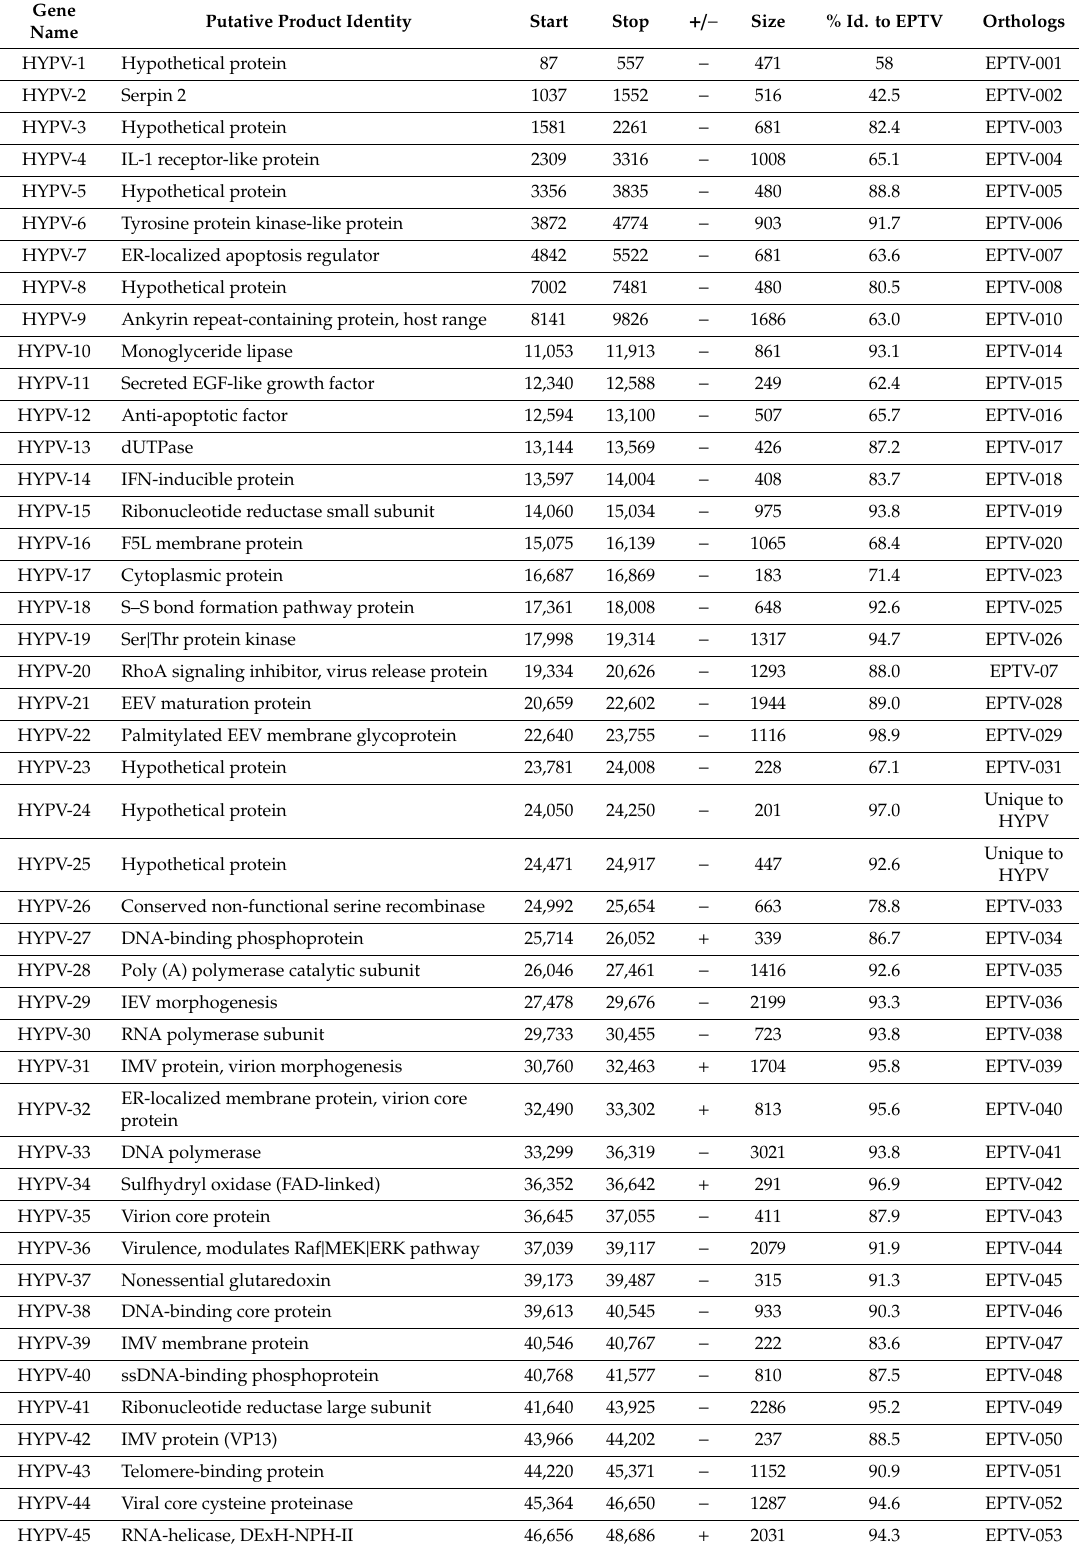
Table 3. HYPV genome annotation and nucleotide identities for each gene to the most similar strain Eptesipoxvirus (EPTV). The seven conserved genes used for phylogenetic analysis in previous studies [10,12] are presented in